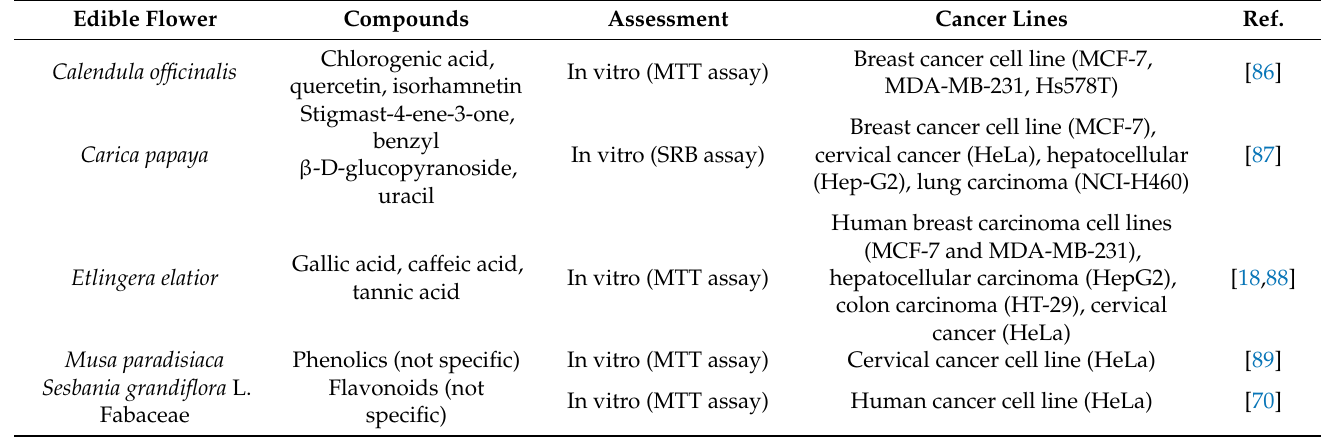
Table 5. Anticancer activities in edible